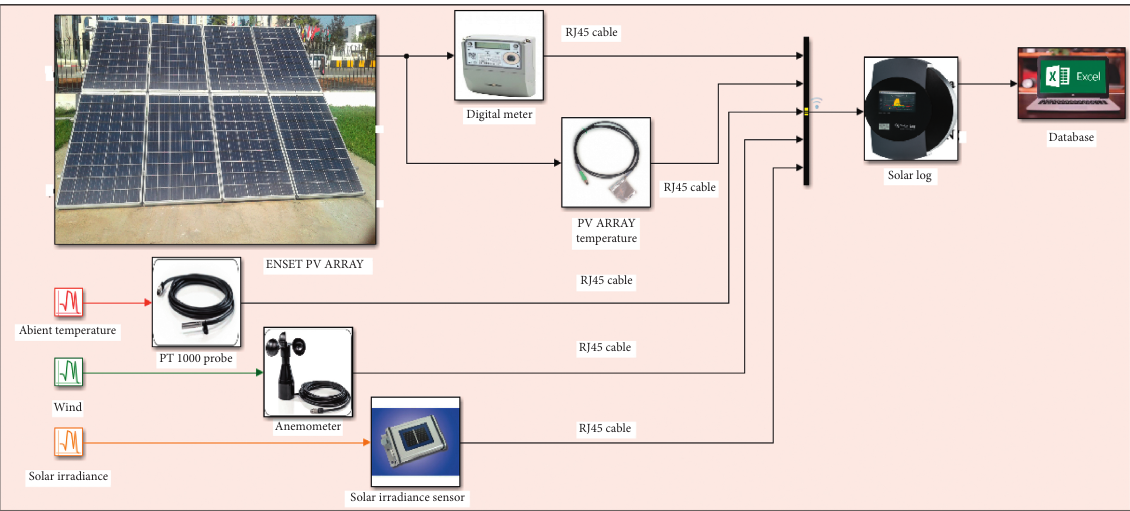
Figure 10: Solar log deployment for the ENSET School PV